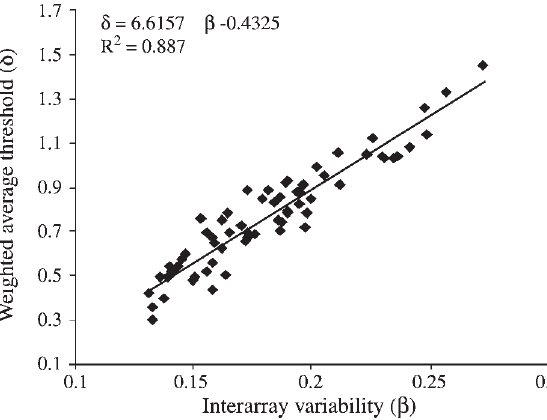
Figure 4 - A linear relationship exists between interarray variability ( β , a measure of experimental variation between two replicate samples calcu- lated from signal intensity) and the weighted average threshold ( δ , the weightedmeanofsix95%confidencethresholdsfromeachreplicatecom- parison as derived from the signal log 2 ratios). There are 65 data points be- cause there are one β and one δ value for each replicate